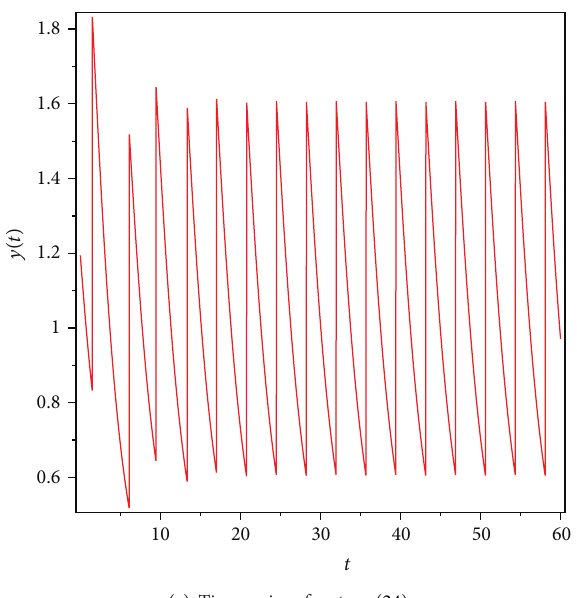
Figure 17: Illustration of basic behavior of system